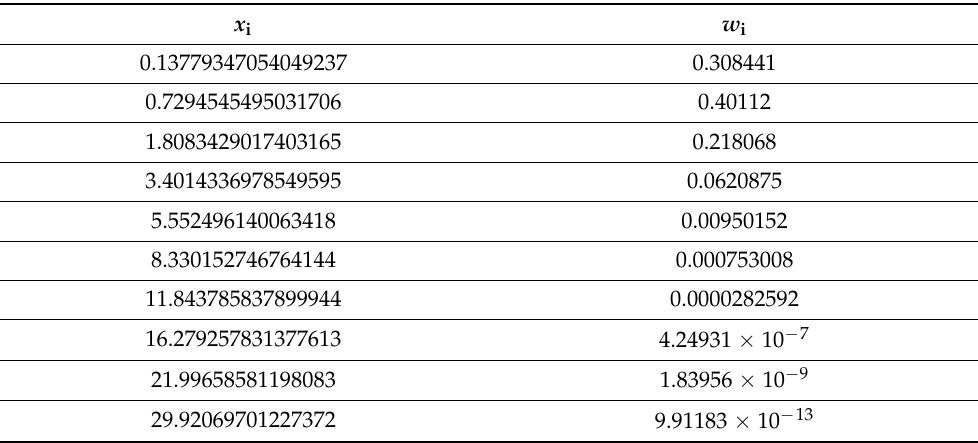
Table 1. Zeros of L 10 ( x ) and corresponding weight